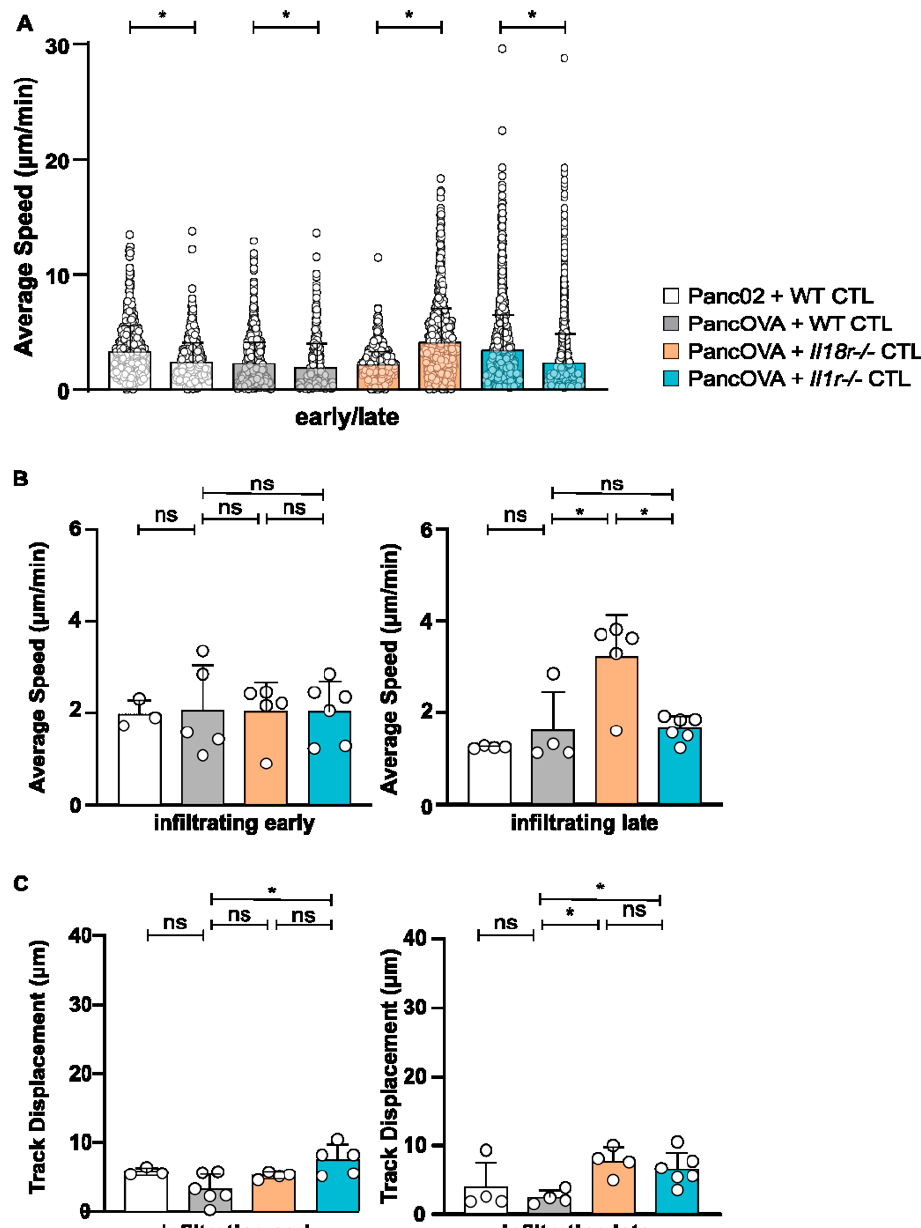
Figure 3. IL18R-deficient CTLs demonstrated increased motility in tumor spheroids compared to that of WT CTLs . The migratory patterns of WT, Il1r − / − , and Il18r − / − CTLs were analyzed with a spot algorithm in Imaris software via 30 min movies of a Panc02/PancOVA tumor spheroid coculture at early (4 h after the start of the T-cell coculture) and late (18 h) time points. ( A ) The average speed of all WT, Il1r − / − , and Il18r − / − CTLs per experiment at the early and late time points. Each dot represents one individual tracked T cell. Graph represents pooled data from n = 3–6 experiments with 431–2761 cells per subgroup. Statistical analysis was performed with the Kolmogorov–Smirnov test; * p < 0.05. ( B ) The average speed of infiltrating WT, Il1r − / − , and Il18r − / − CTLs at the early and late time points. The mean of every experiment ( n = 3–6) is shown as a dot. An unpaired, two-tailed t -test was performed; * p < 0.05. ns = not significant ( C ) Track displacement indicating the directed motility of infiltrating WT, Il1r − / − , and Il18r − / − CTLs at the early and late time points. The mean of every experiment ( n = 3–6) is shown as a dot. An unpaired, two-tailed t -test was performed; * p < 0.05. ns = not significant